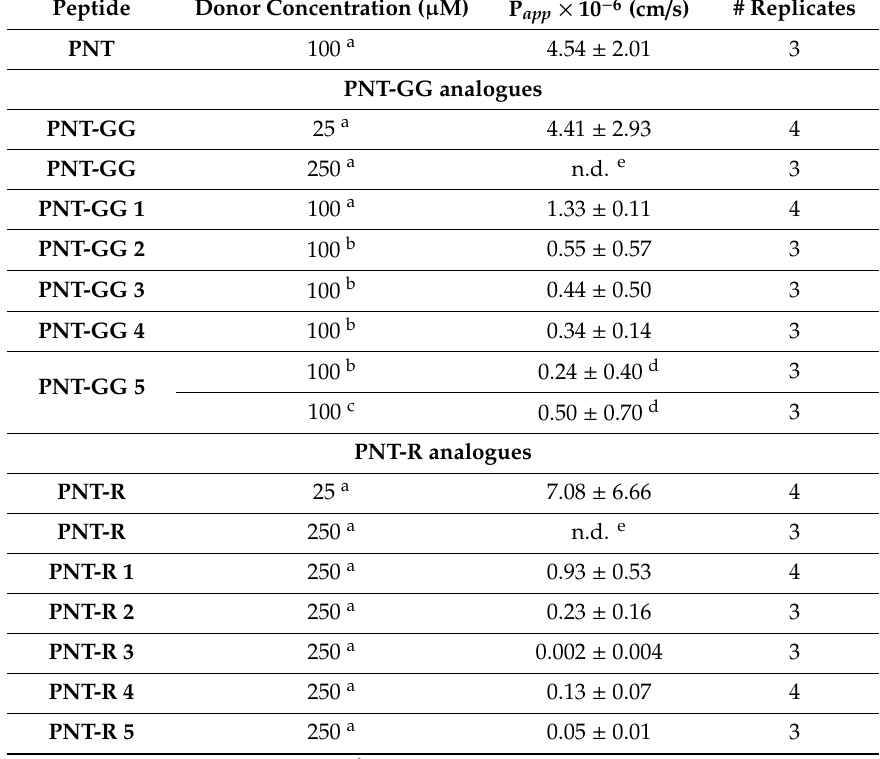
Figure 1. Trans-corneal permeation profiles of PNT (donor solution 100 µ M; panel ( a )) and PNT-GG and PNT-R (donor solution 25 µ M; panel ( b )). (mean value ± sem). Table 2. Donor concentrations and apparent permeability coefficients calculated using Equation (1).